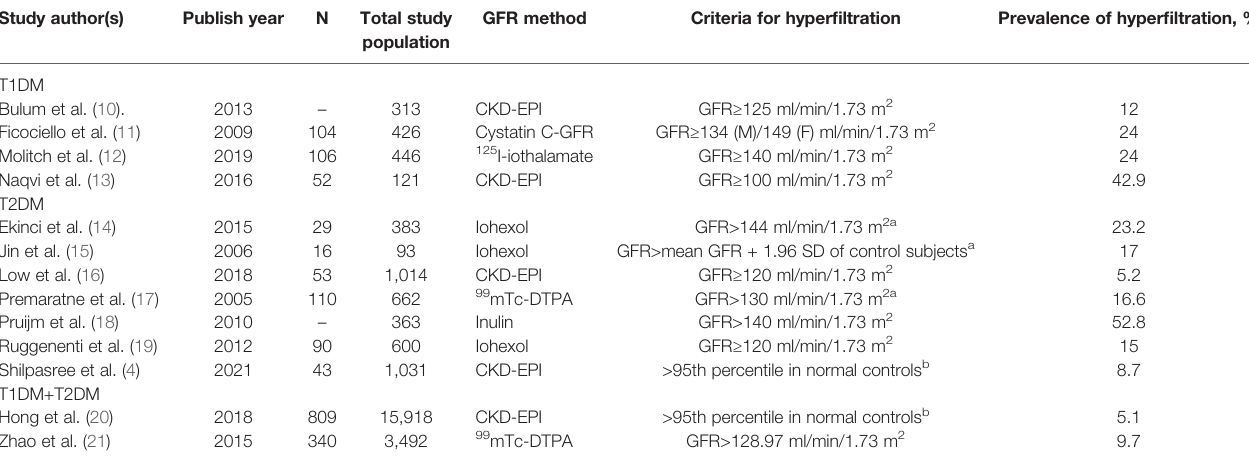
TABLE 1 | Prevalence of diabetic hyper fi ltration in recent